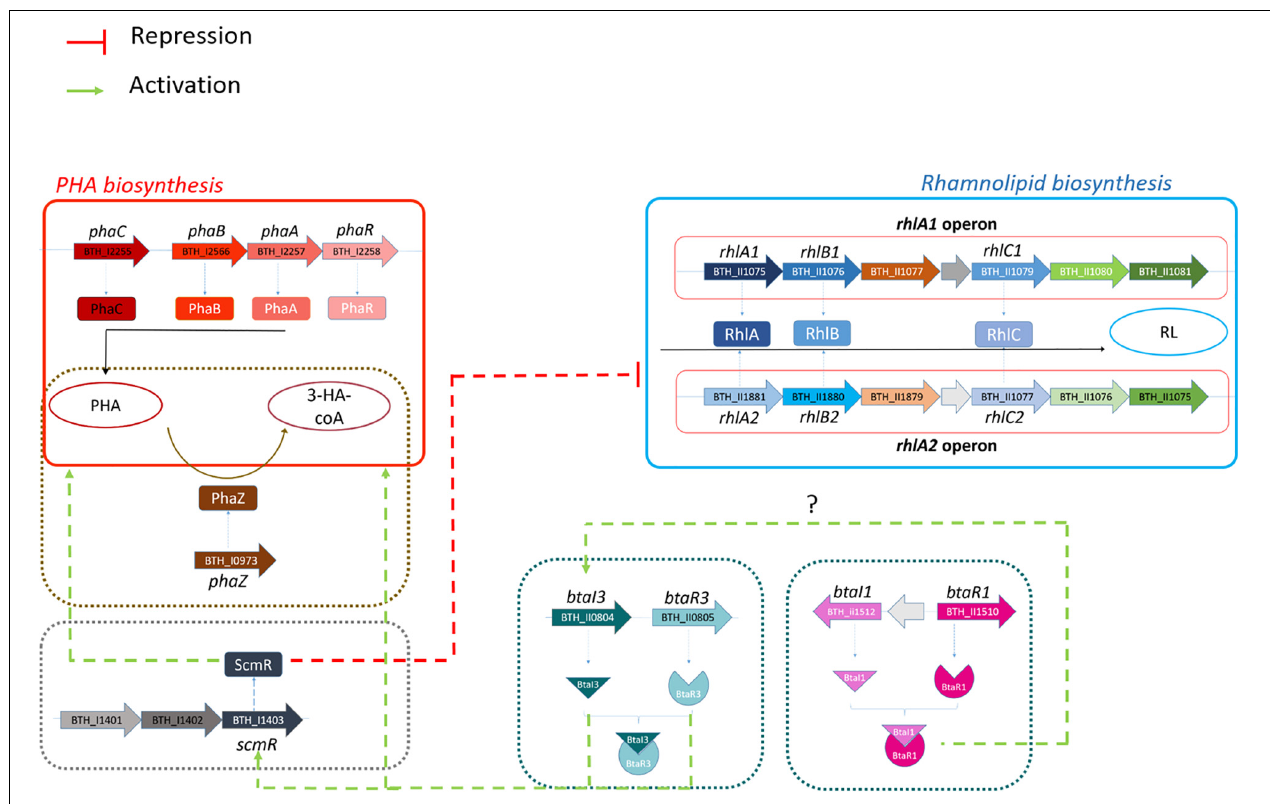
FIGURE 9 | Proposed regulation of rhamnolipid and PHA productions through ScmR and quorum sensing systems in B. thailandensis E264. Rhamnolipid and PHA biosynthesis pathways are presented in red and blue, respectively. The involvement of ScmR, QS-1 and QS-3 on rhamnolipid and PHA production are represented using green dotted arrows for activation or red dotted lines for the repression. Dotted arrow lines indicate that direct regulation has not been